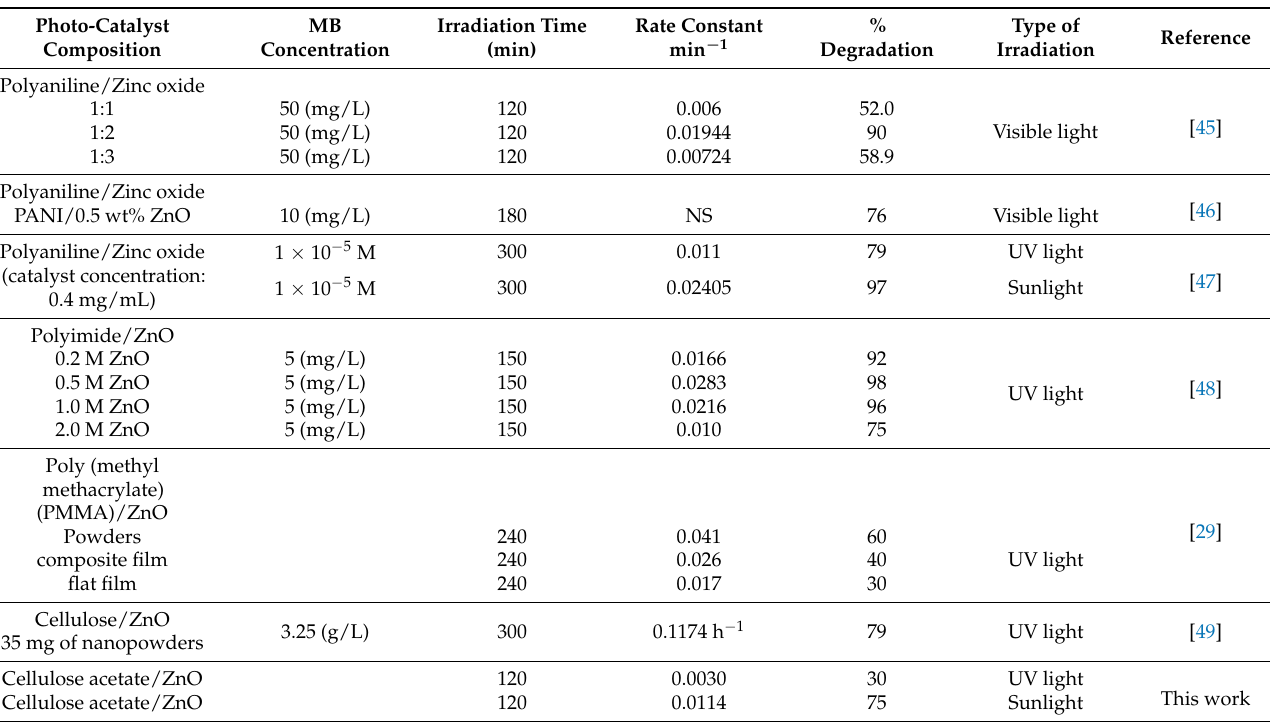
Table 2. Comparison of MB Dye degradation in different